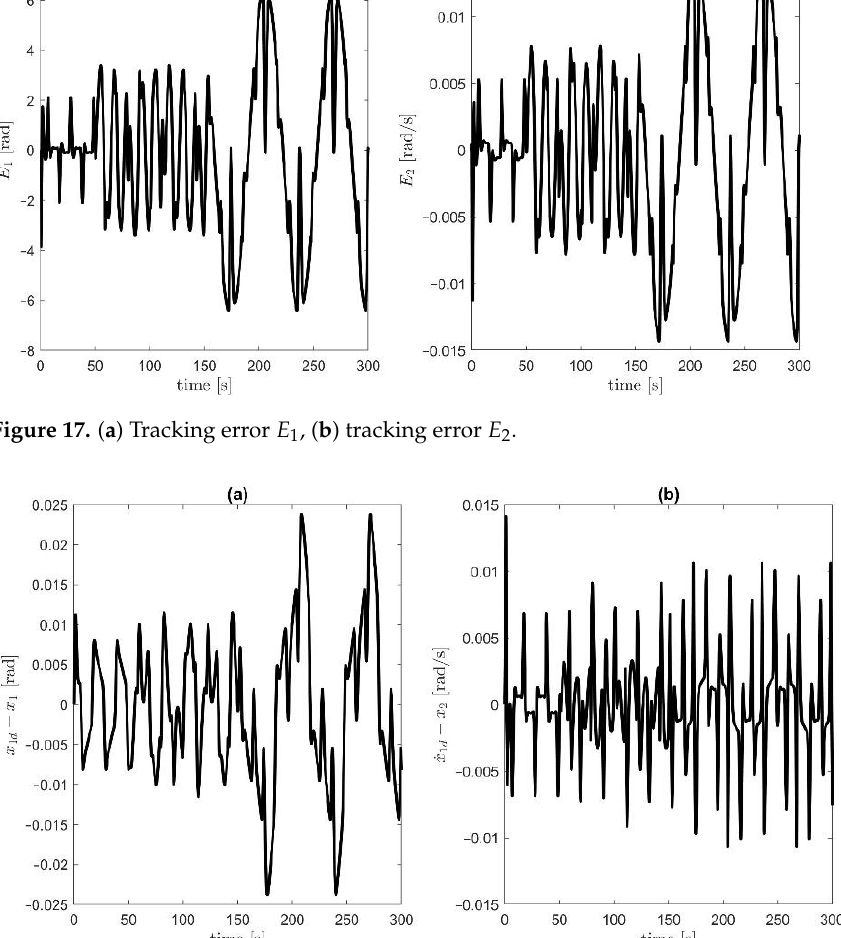
Figure 18. ( a ) Tracking error 𝑥 1𝑑 − 𝑥 1 , ( b ) tracking error 𝑥̇ 1𝑑 − 𝑥 2 .